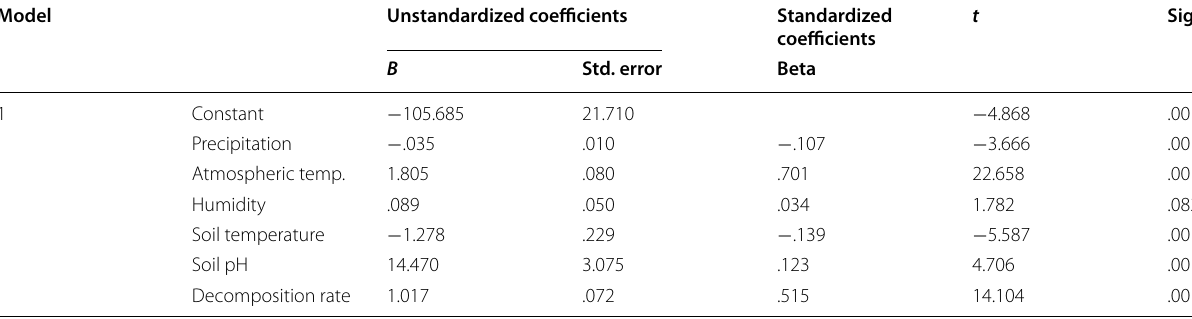
Table 11 Coefficients of the regression model for time of death